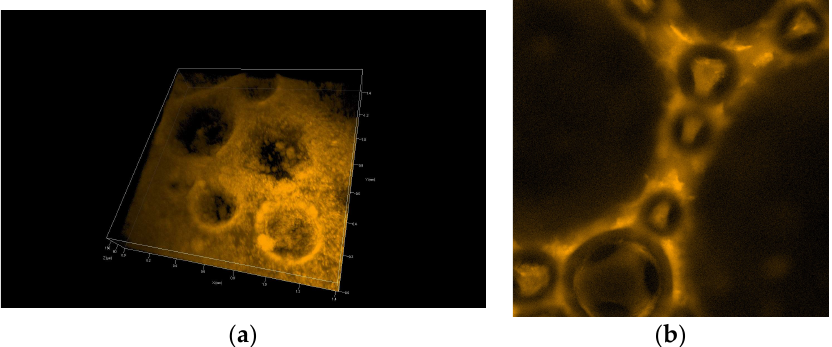
Figure 8. Confocal microscopy photo of the foam generated from the chitosan—LAE—Levasil ® 100/45% (30 nm) mixture—3D structure ( a ) and 2D photo ( b